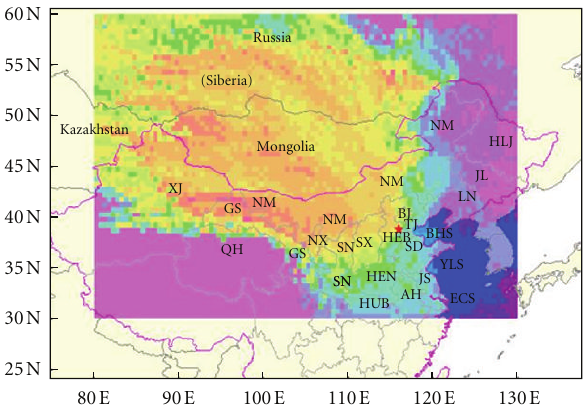
Figure 9: Distribution of possible source regions passed by backward trajectories to Lake Small Baiyangdian in four seasons. HEB:Hebei, HEN:Henan, HUB:Hubei, BJ:Beijing, TJ:Tianjin, SD:Shandong, JS:Jiangsu, AH:Anhui, SX: Shanxi, SN: Shaanxi, NX:Ningxia, GS:Gansu, QH: Qinghai, XJ:Xinjiang, NM:Neimeng, HLJ:Heilongjiang, JL:Jilin, Ln: Liaoning, BHS :Bohai Sea, YLS:Yellow Sea, ECS: East China